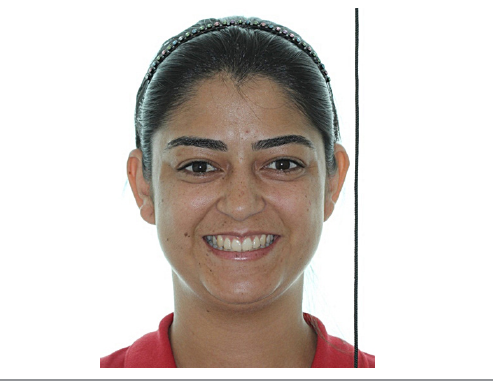
Figure 2. Examples of data collected. Group 1 (age 20-29).